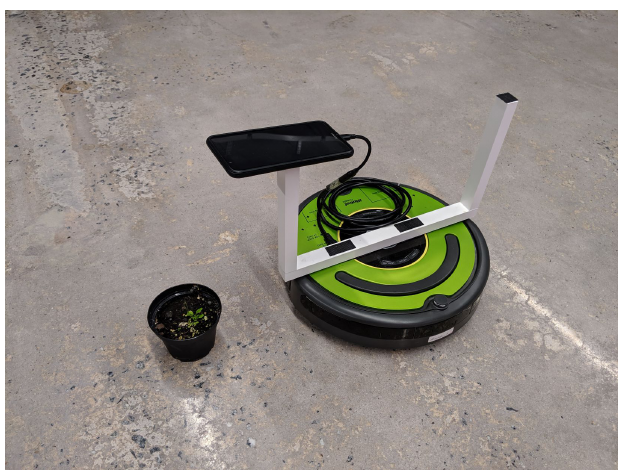
Figure 2. Deployed platform for data acquisition and real-time data processing.